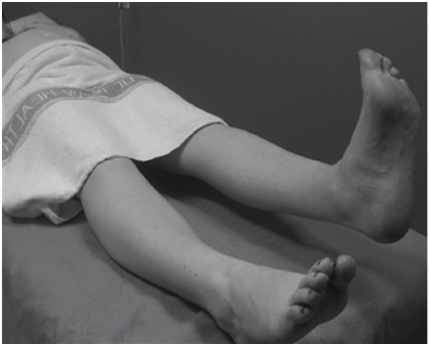
Figure 7: The active straight leg